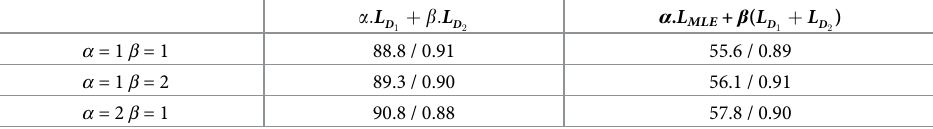
Table 7. PPL and BLEU scores with weighted discriminator and MLE loss for the topical chat frequent test